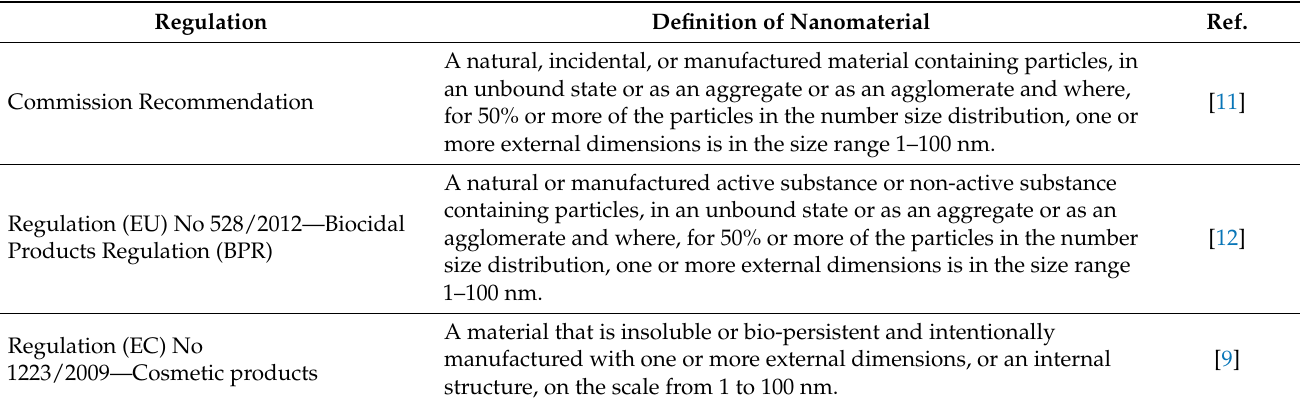
Table 1. Classification/definition of nanomaterials based on prevalent regulatory